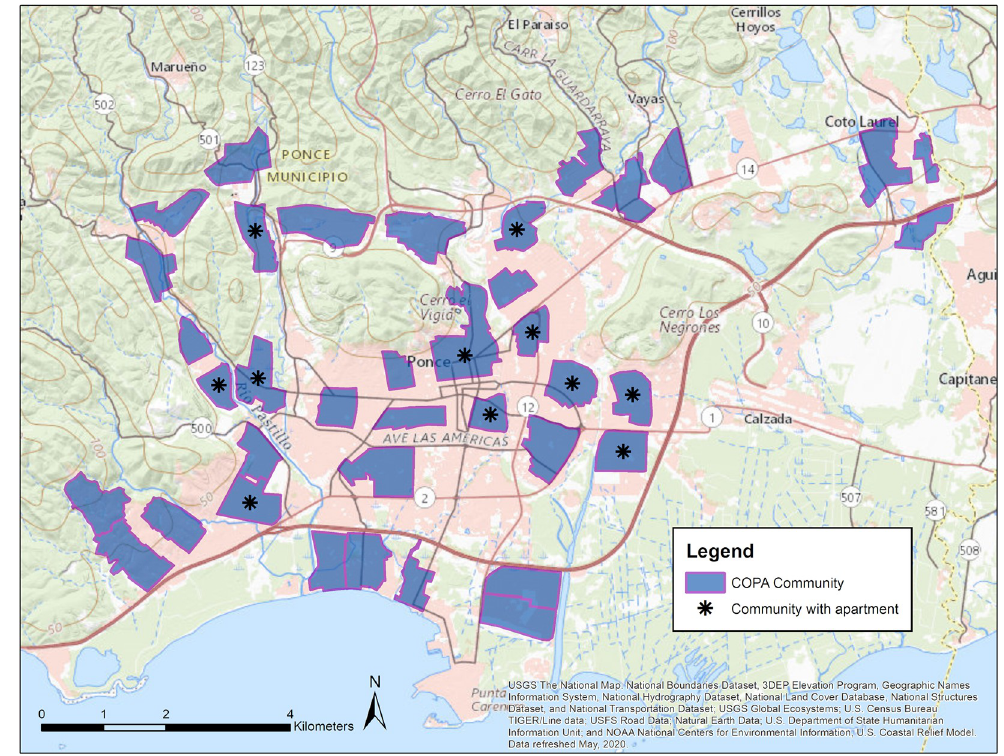
Fig 6. COPA communities. COPA communities, including all 38 clusters, are shown in light blue. Communities with asterisks indicate communities with apartment buildings.